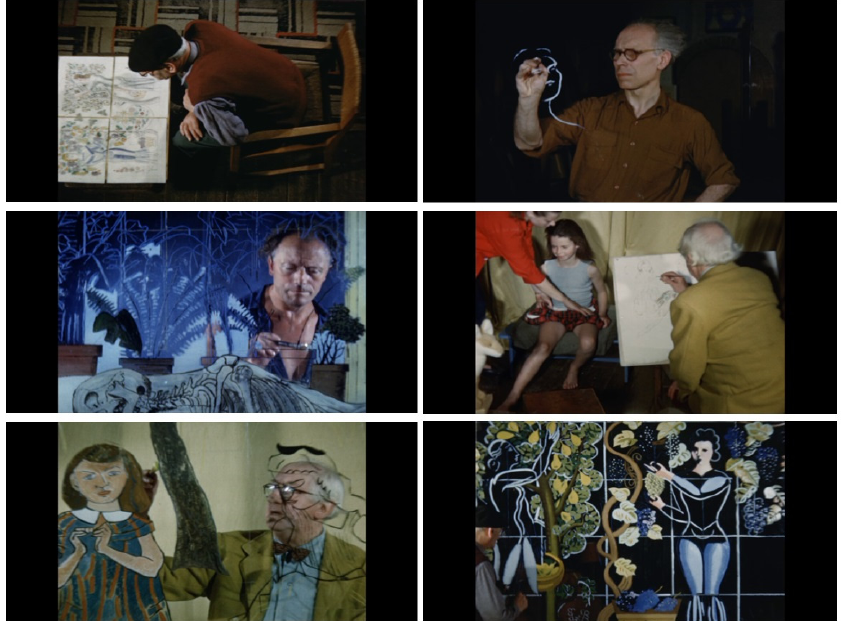
Figure 5. Paul Haesaerts, Quatre peintres belges au travail , 1952 (digital film frames). From left to right, these panels illustrate: Paul Delvaux studying his sketches for his painting on death and winter; Dasnoy drawing the outlines of his painting on youth and summer on his glass pane; Paul Delvaux painting on his glass surface, a girl posing for Edgar Tytgat’s painting on childhood and spring in his studio; Edgar Tytgat painting on his glass pane; Jean Brusselmans’s painting on adulthood and autumn’s work in progress.